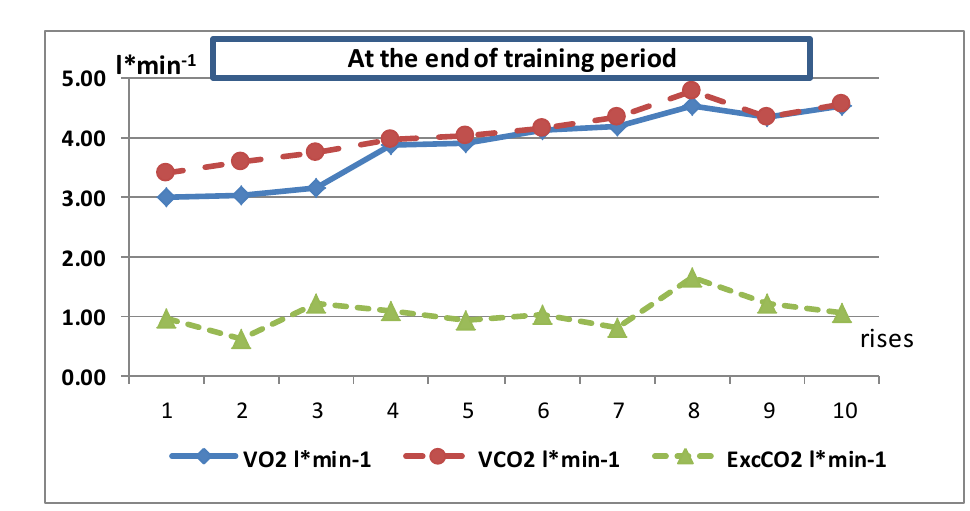
Fig.1. Dynamic of changes of oxygen consumption indicators (VO 2 ), release of СO 2 (VСO 2 ) and its excess (ExcCO 2 ) in elite female skiers on rises of different difficulty at the beginning and at the end of training period.